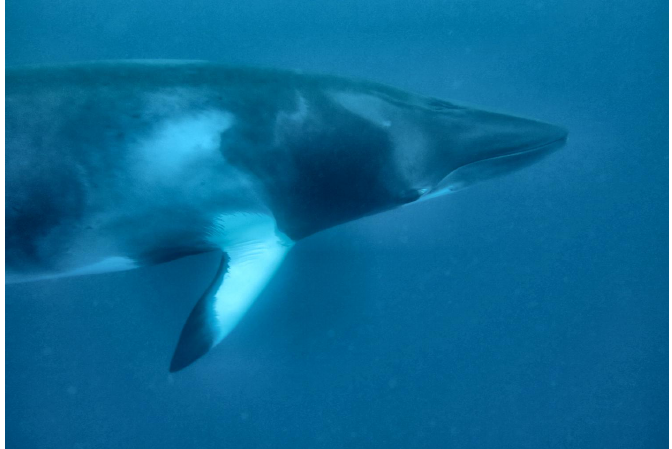
Figure 1. An example of individual dwarf minke whale distinct colour patterns. Image was enhanced by the Contrast Limited Adaptive Histogram Equalization (CLAHE) algorithm